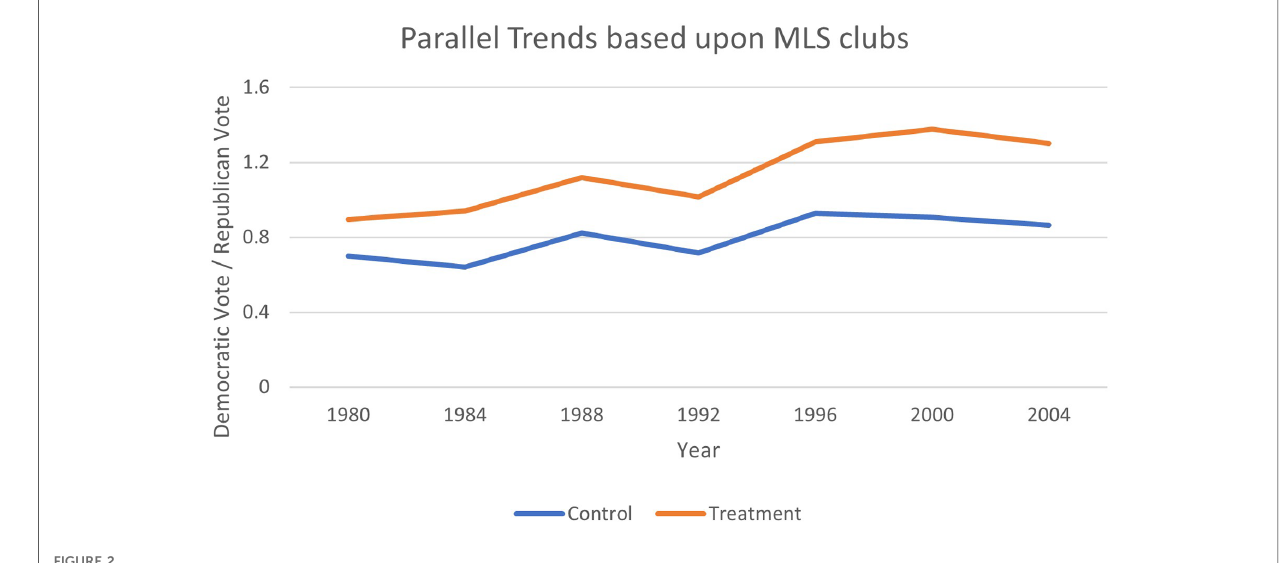
FIGURE 2 Testing parallel trends for MLS